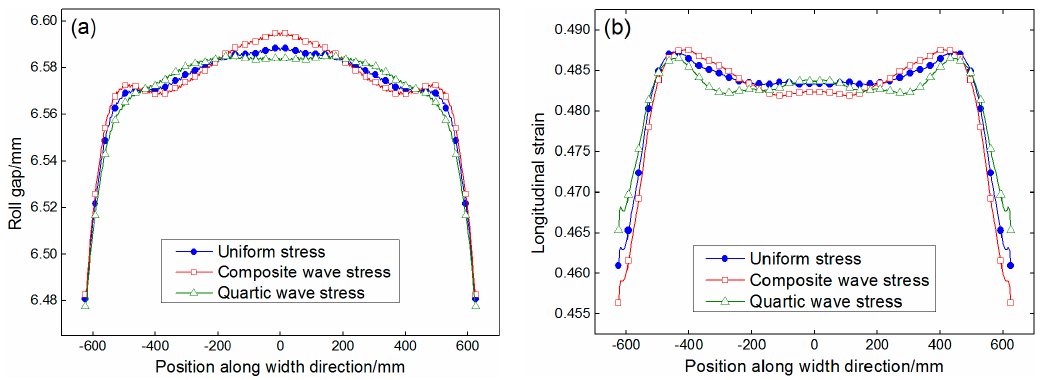
Figure 14. Effect of quartic wave stress on the roll gap profile and longitudinal strain: ( a ) effect on the roll gap profile; and ( b ) effect on the longitudinal strain.